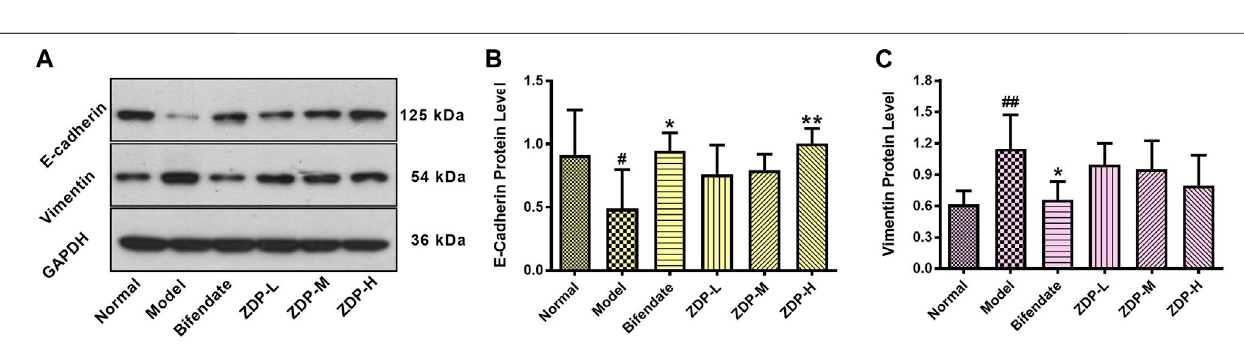
FIGURE 8 | Effects of ZDP on protein expression of E-cadherin and Vimentin in hepatic tissues of the murine model of ALI induced by CCl 4 . (A) Equal protein quantities oflysates from mouse liver tissues (Normal control, Model control, Bifendate-treated control, ZDP-L,ZDP-M and ZDP-H) were subjected to Western blot with antibodies against E-cadherin, Vimentin and GAPDH. E-cadherin (B) and Vimentin (C) protein intensities were quanti fi ed by densitometry, and normalized to respective GAPDHlevels.Datafromsixmicepergroupareexpressedasthemean ± SD.Statisticalanalysis: # p < 0.05, ## p < 0.01comparedwiththenormalgroup;* p < 0.05, ** p < 0.01 compared with the model group, One-Way